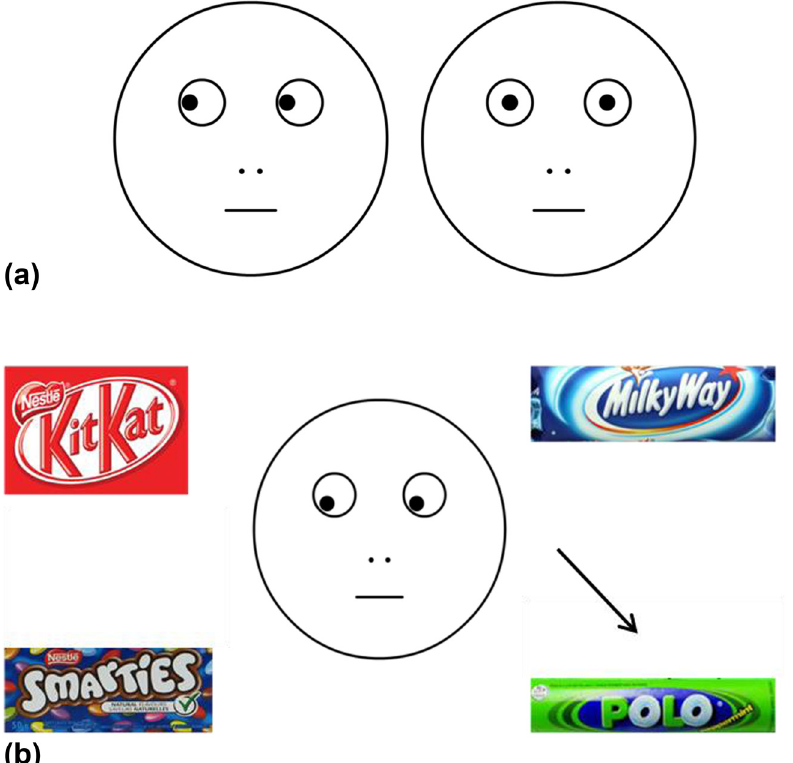
Figure 4: ( a ) Example question from the Charlie test: the child is asked “ Which face is looking at you?. ” ( b ) Example question from the Charlie test: the child is fi rst presented with the pictures of four sweets only and asked “ Which one is your favourite?. ” Once the child gives an answer, the face referred to as Charlie is placed in the middle looking at one of the sweets, along with an arrow pointing at a third sweet, and the child is then asked “ What is Charlie looking at?.